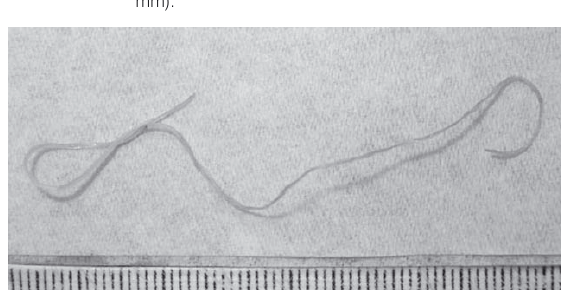
Figure 1. Adult female Dirofilaria repens extracted from the left eye of a 48-years-old patient (length: 11.5 cm, diameter: 0.5